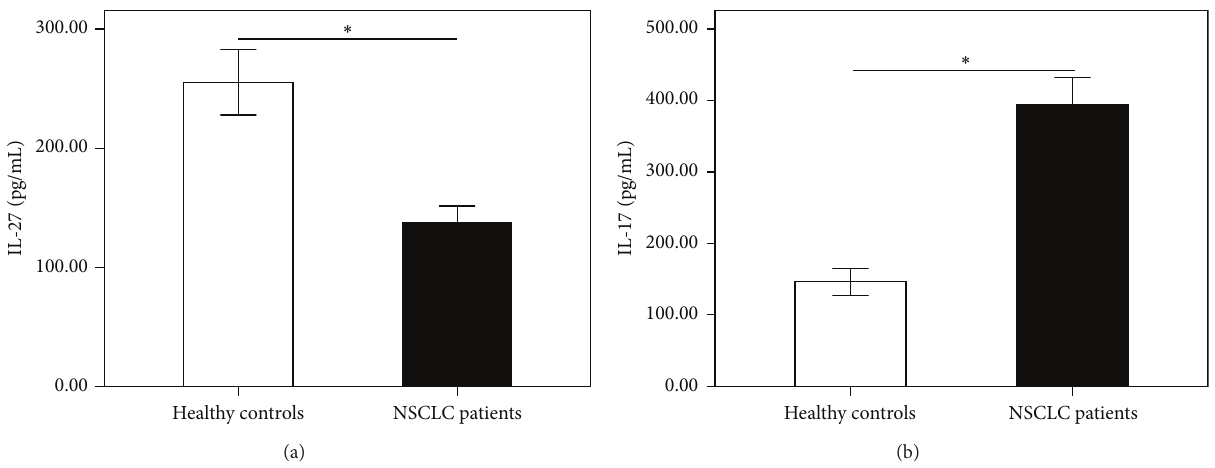
Figure 1: The levels of IL-27 and IL-17 were measured by using ELISA. Serum IL-27 levels (a) were significantly decreased in NSCLC patients as compared to healthy controls. IL-17 levels (b) in serum were significantly higher in NSCLC patients than in healthy controls. Results are expressed as pg/mL (mean ± SD). 𝑛 = 19 ; ∗ 𝑃 < 0.001 .